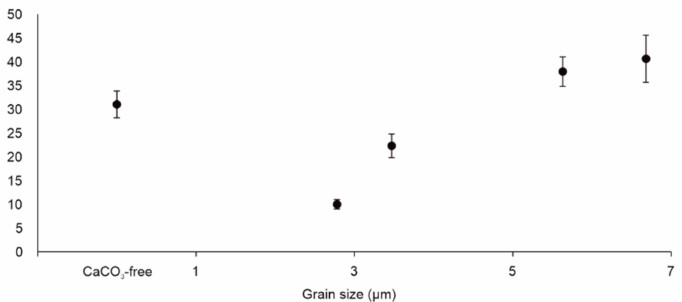
Figure 8. Roughness values S a versus grain size of CaCO 3 particles for scratch surfaces after the scratch test.